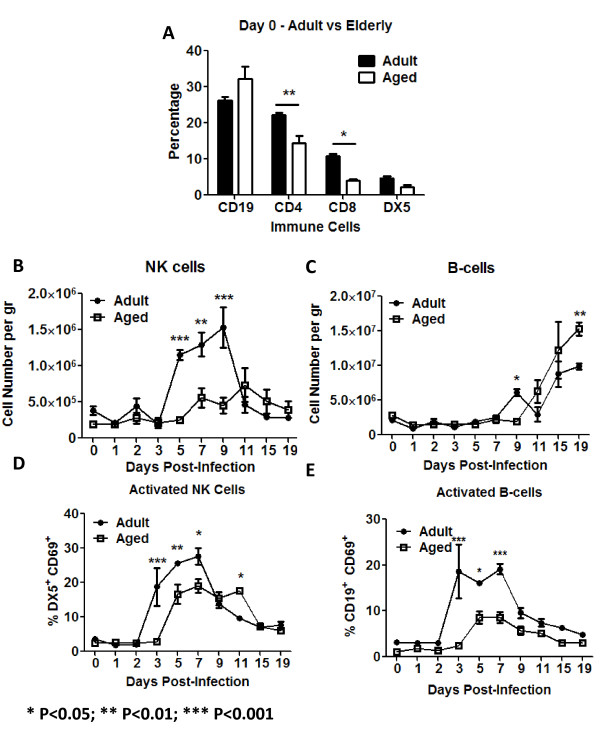
Lymphocytic cells. Several innate and adaptive lymphocytic cells were analyzed in the lungs of aged and adult mice. CD4+ and CD8+ T-cells were more abundant in adult mice (black bars) at day 0 (A). Adult mice (black circles) had a significantly higher infiltration of NK (DX5) cells in the lungs (B). The kinetics of B-cell lung infiltration, on adult (black circles) and aged (white squares) mice were similar (C). Expression of the early activation marker CD69 by NK and B-cells was detected earlier and at a higher percentage in adult mice in (black circles) (E and F), which suggested that despite similar infiltration kinetics, adult B-cells started to produce antibodies earlier. This was confirmed later when HAI were performed (Fig. 8). The graphs represent cumulative results of two different experiments. The arithmetic means (± SEM) of the number of cells (C and D) or percentages (A, D and E) at each time point (4-6 mice per time point) were plotted. Stars indicate statistical difference between aged and naïve animals. *P < 0.05. **P < 0.01. ***P < 0.001.